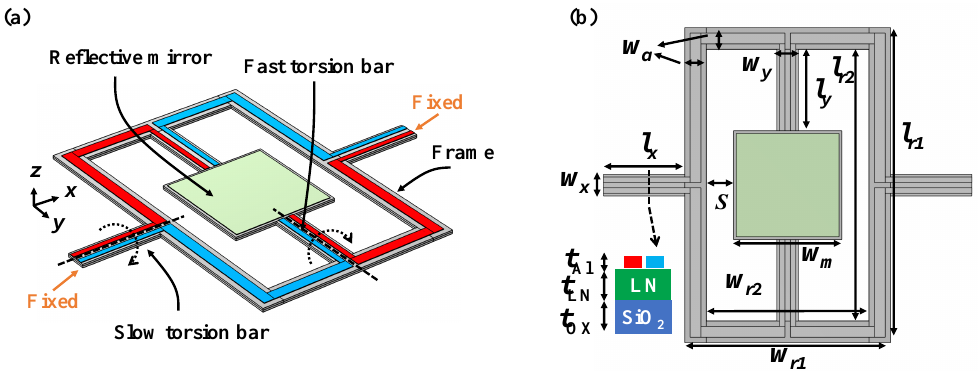
Figure 3. ( a ) Schematic view and electrode configuration; ( b ) Top view of the proposed 2D MEMS resonant scanner with the main geometry dimensions and the cross-section of the torsion